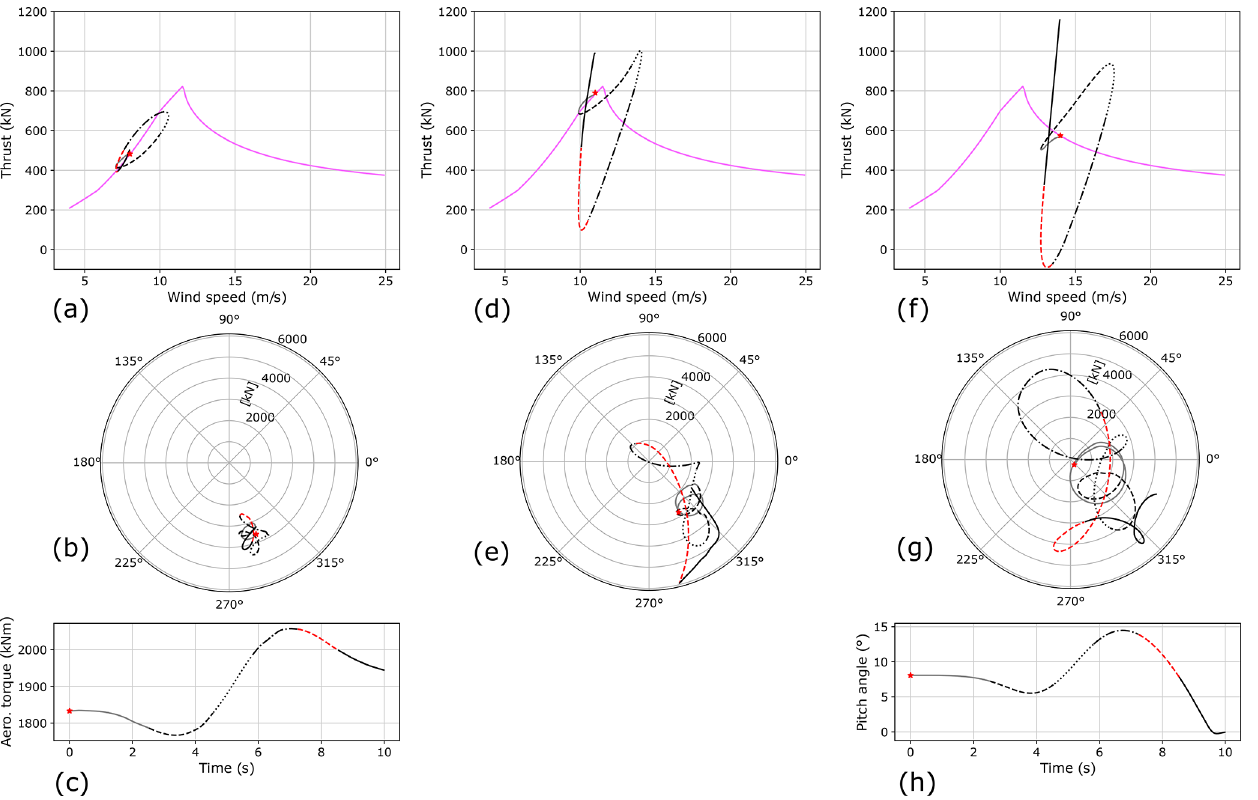
Figure 12. Radial and axial main-bearing loads on the upwind row of the overhung support configuration, along with control variable values, resulting from gusts at v = 8ms − 1 (a–c) , v = 11ms − 1 (d, e) , and v = 14ms − 1 (f–h) . Line segments in this figure correspond to those in